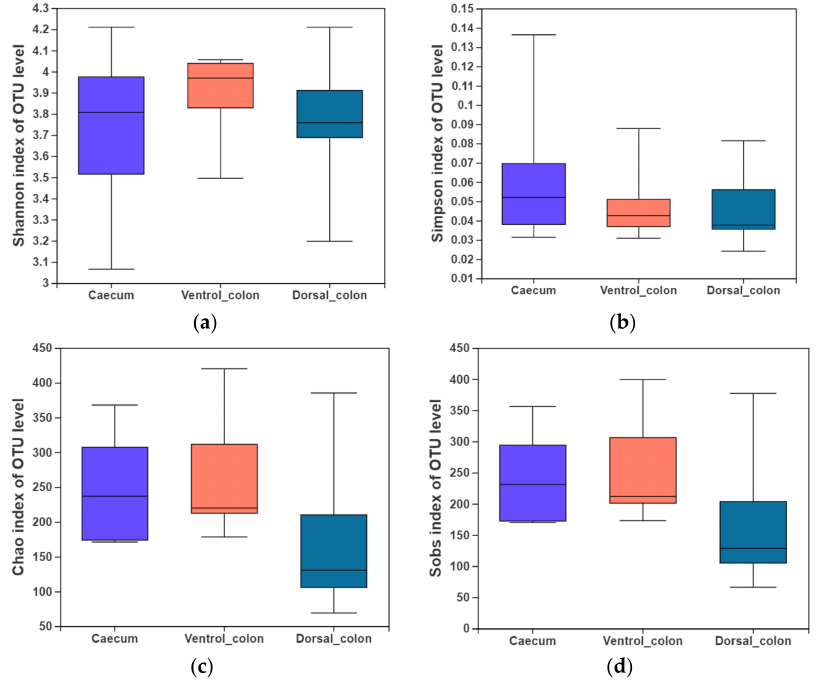
Figure 1. Fungal alpha diversity indices of caecum and colon in Dezhou donkeys. ( a ), Shannon index; ( b ), Simpson index; ( c ), Chao index; ( d ), Sobs